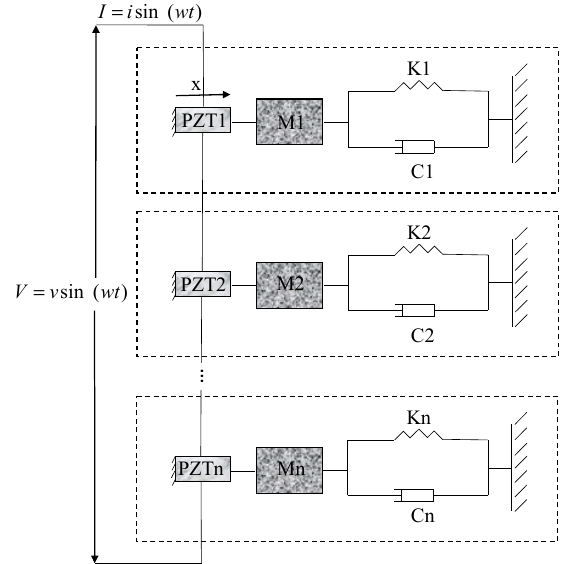
Figure 2. The schematic diagram of the multi-sensing electro-mechanical impedance (EMI) method.